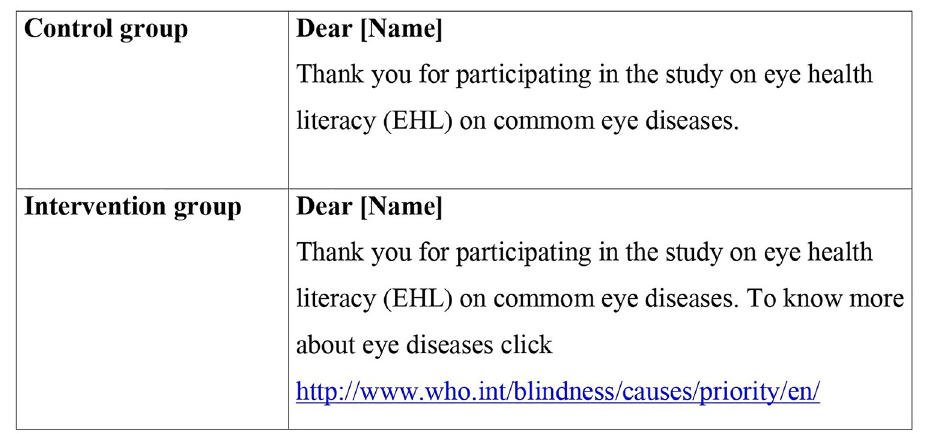
Fig 1. Tailored text message for intervention and control